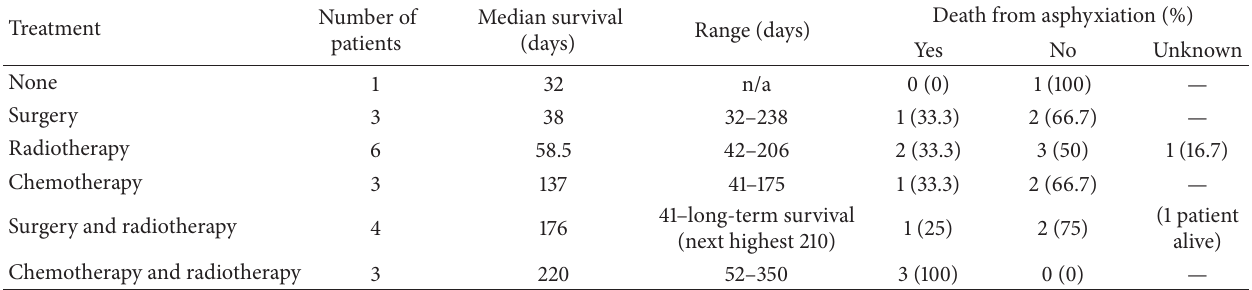
Table 1: Number of patients receiving each treatment modality and percentage dying from asphyxiation.